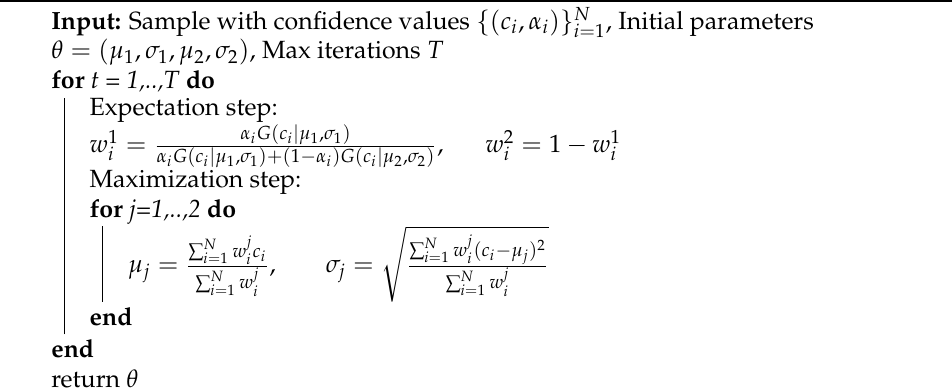
Algorithm 1: Gaussian mixture EM with sample confidence